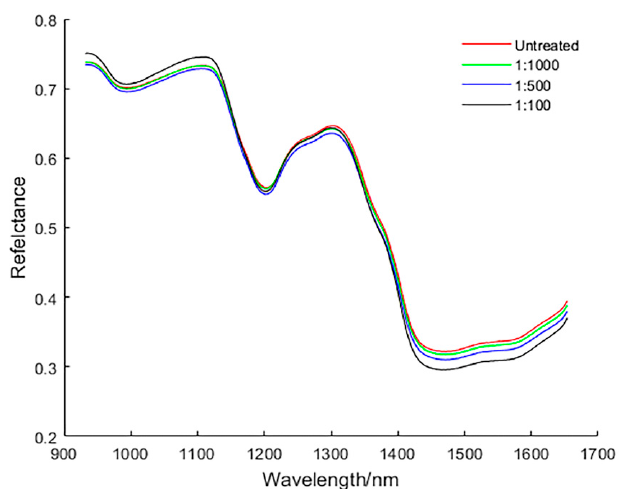
Figure 4. Average spectral curves of wheat grains with different concentrations of omethoate.